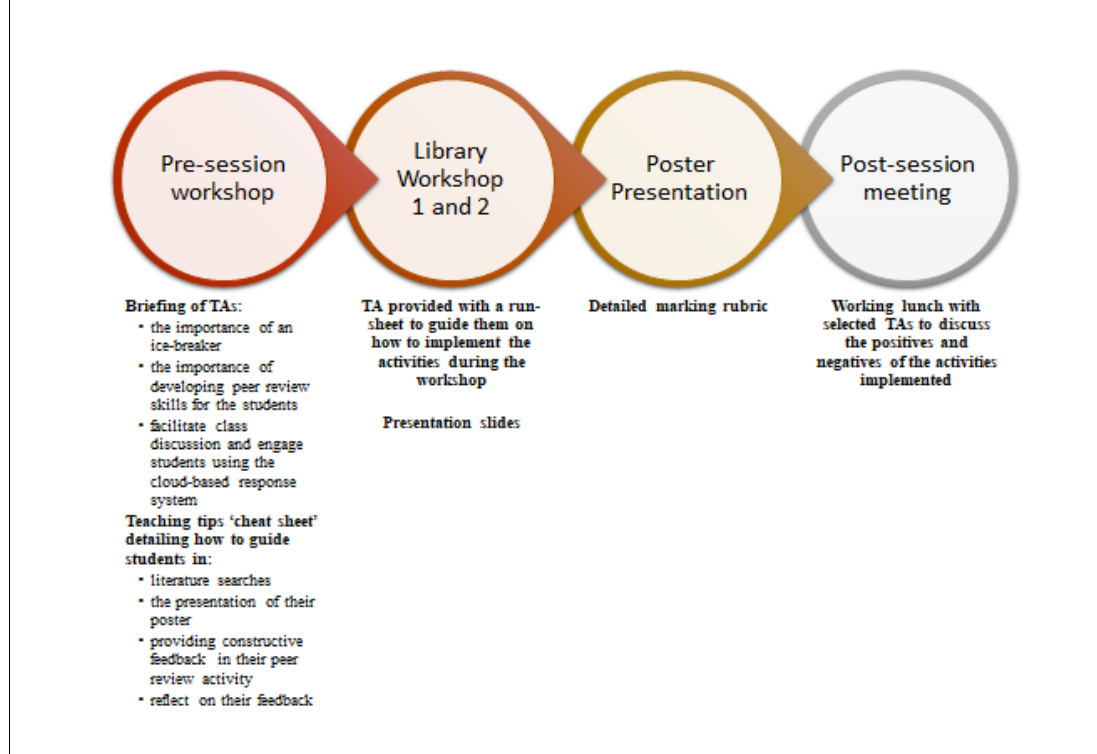
Figure 2 . A schema of the resources developed to support Teaching